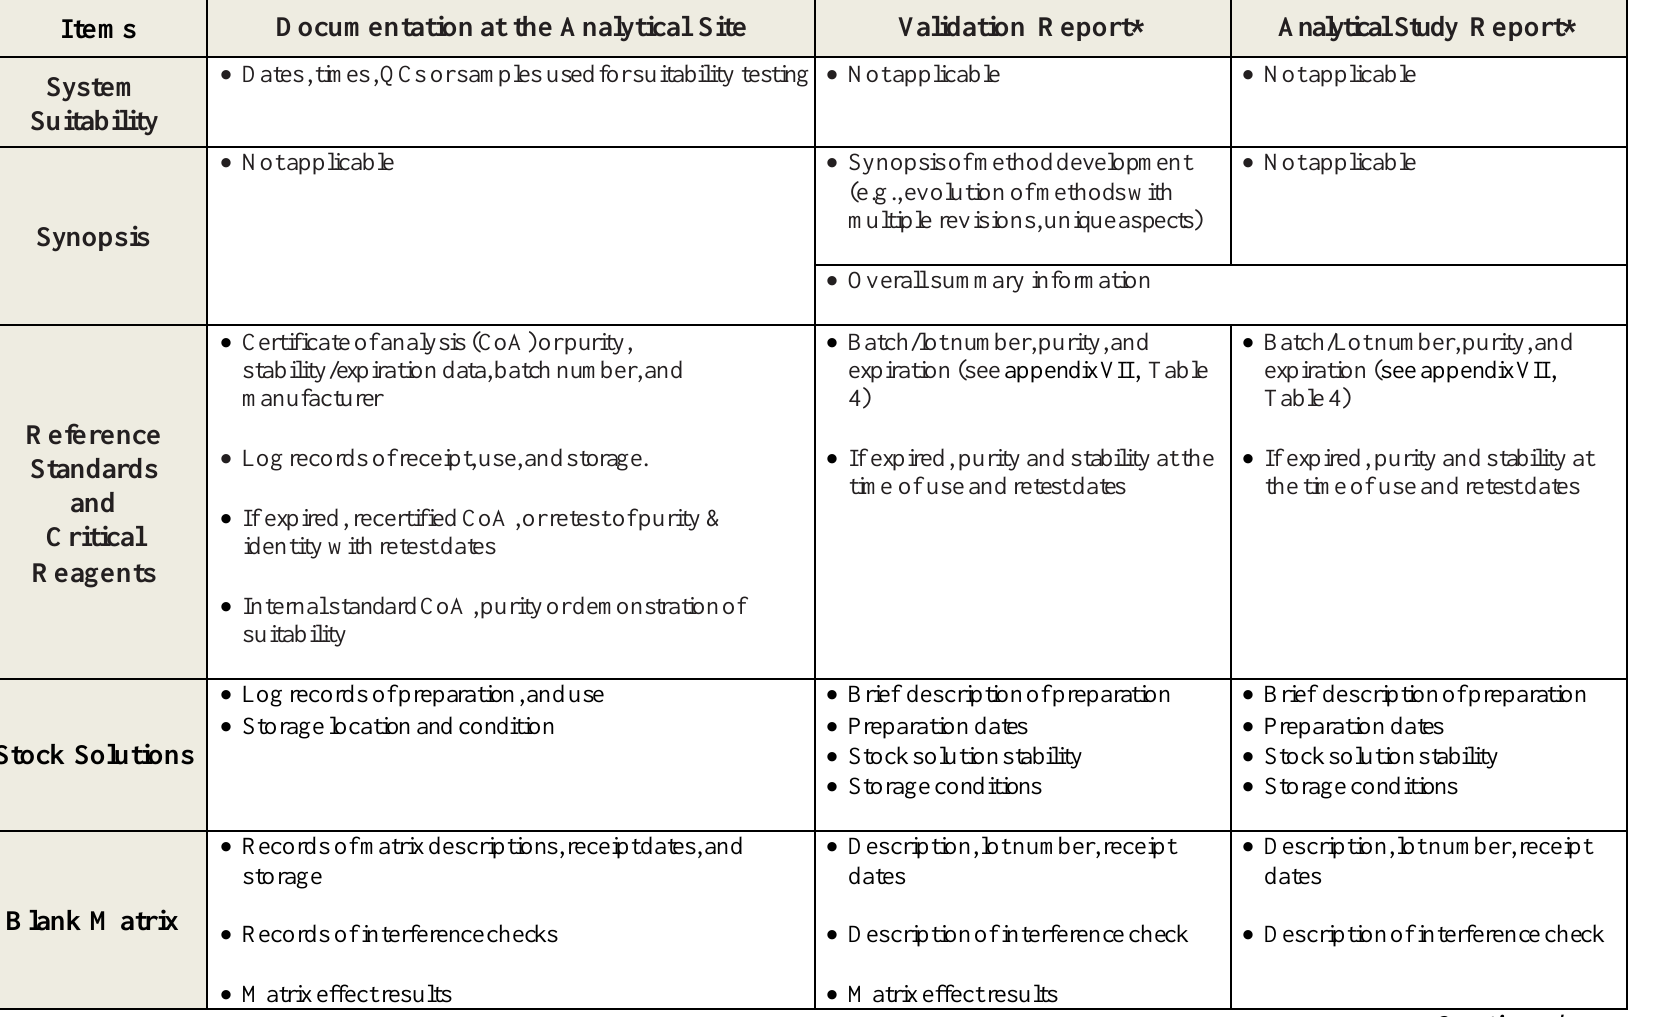
Table 2. Documentation and Reporting (refer to sections III.B and VI for additional